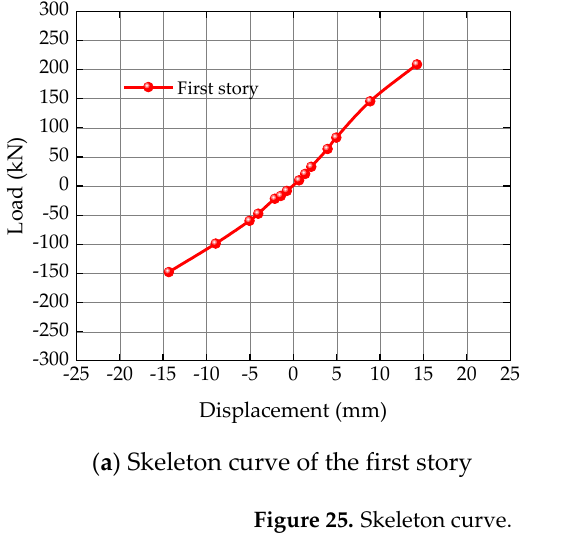
Figure 25. Skeleton curve.